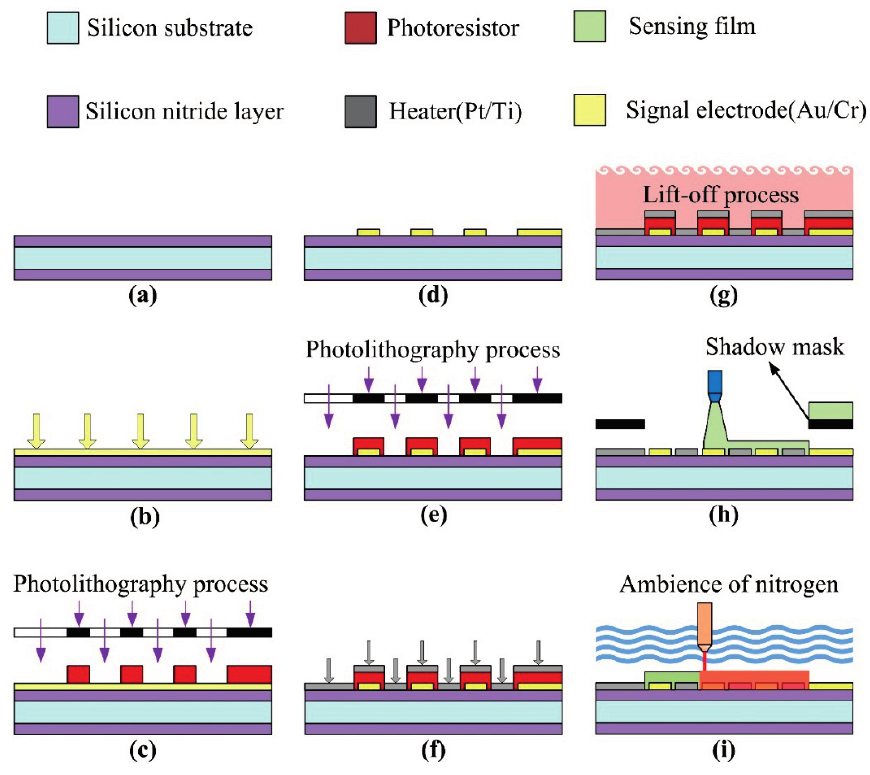
Figure 3. Process flow for the ZnO gas sensor.